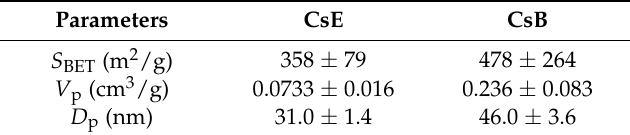
Figure 3. N 2 adsorption and desorption BET isotherms of ( A ) CsE and ( B ) CsB aerogels. Table 2. Specific surface area ( S BET ), pore volume ( V p ) and pore diameter ( D p ) of the CsE and CsB aerogels.